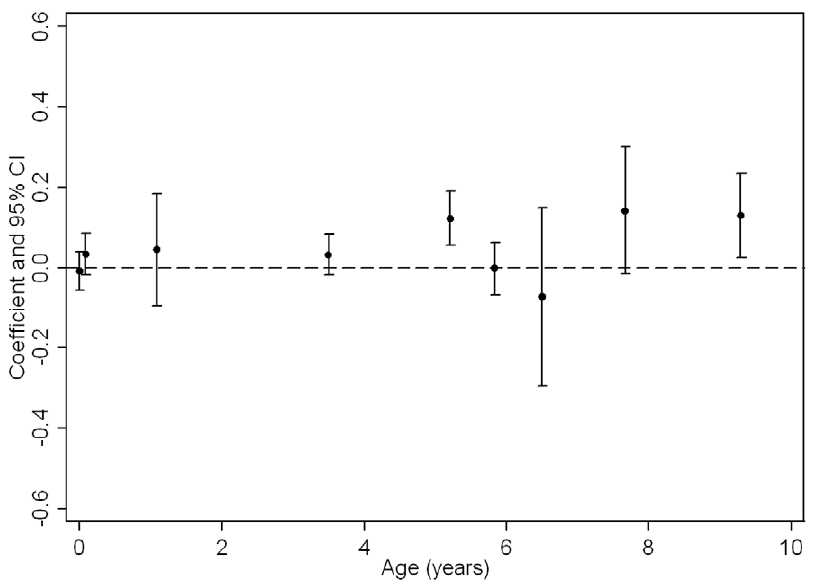
Figure 5. Boys Coefficients and 95% confidence intervals from standardised linear regressions of log triglycerides at age 15 on PI/ BMI trajectories (age in years along x-axis is the mid-point of PI/BMI change periods; coefficients are adjusted for confounders and previous PI/BMI changes, i.e. Model 3 in Tables).